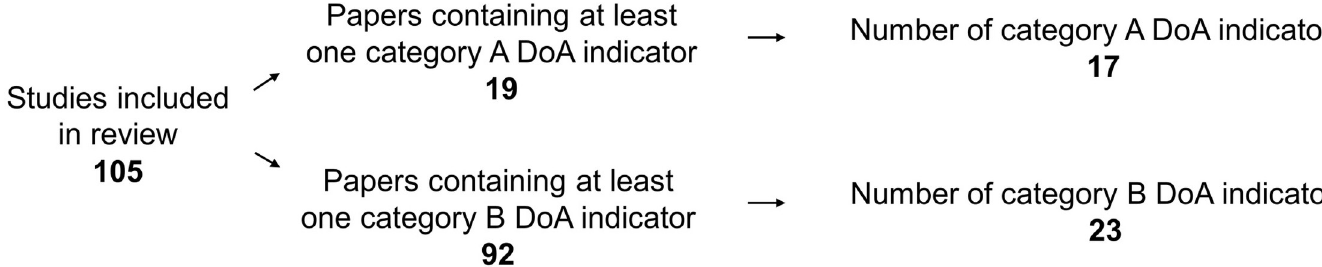
Fig 2. Categorisation of the depth-of-anaesthesia (DoA) indicators. The sum of the papers containing at least one category A or B DoA indicator exceeds the total number of studies included in the review, since some papers included both category A and category B DoA indicators.